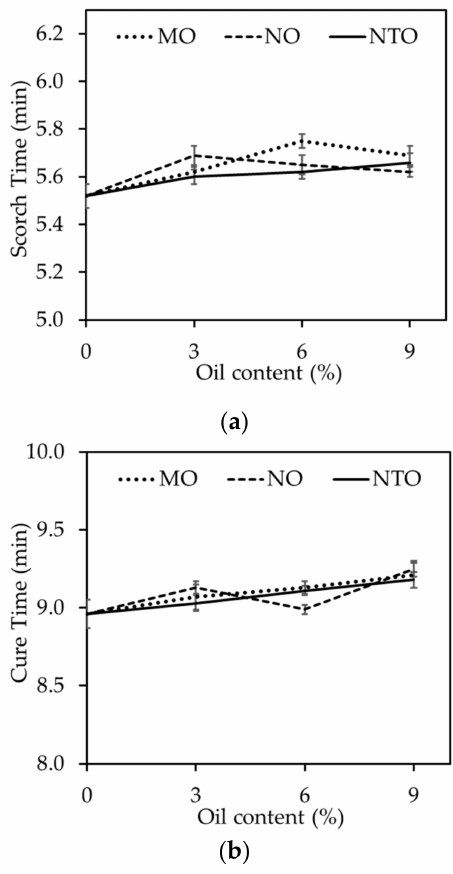
Figure 2. ( a ) Scorch time and ( b ) cure time of the rubber compounds comprising different oil types and contents.